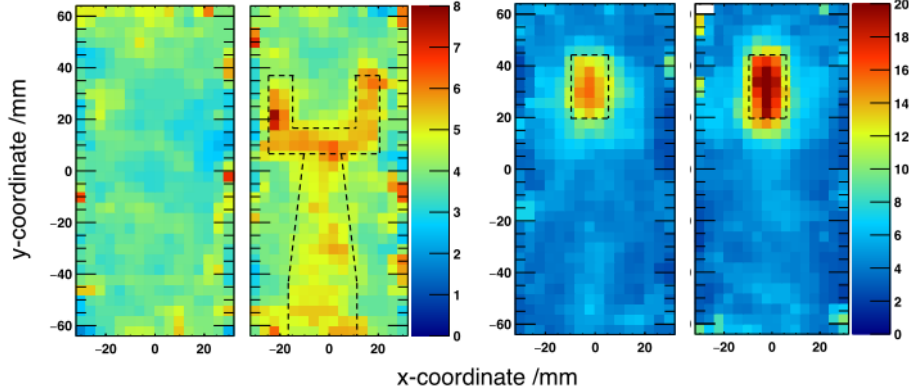
Figure 12. Experimental reconstructed images with 45,000 muons. The black dotted lines show the sample contours. From left to right: air, plastic holder, iron and lead samples. Reproduced from